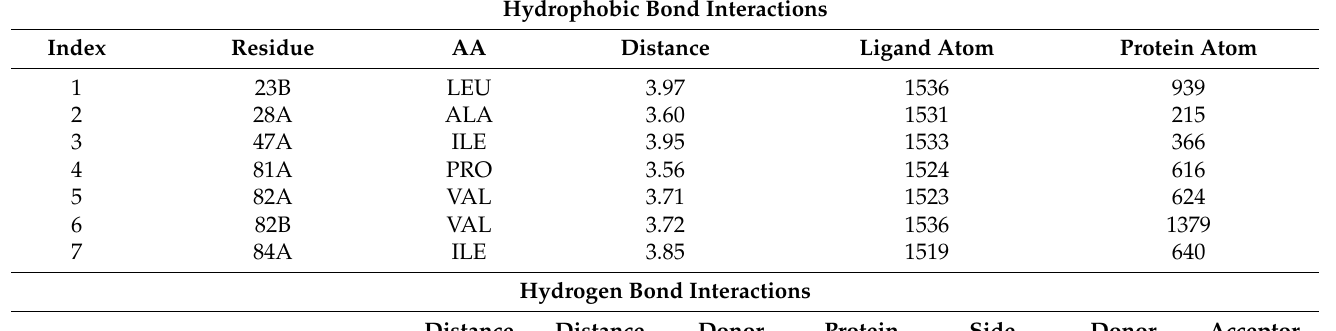
Table 2. Hydrophobic and Hydrogen bond interaction details of HIV-1RT and C-PC.